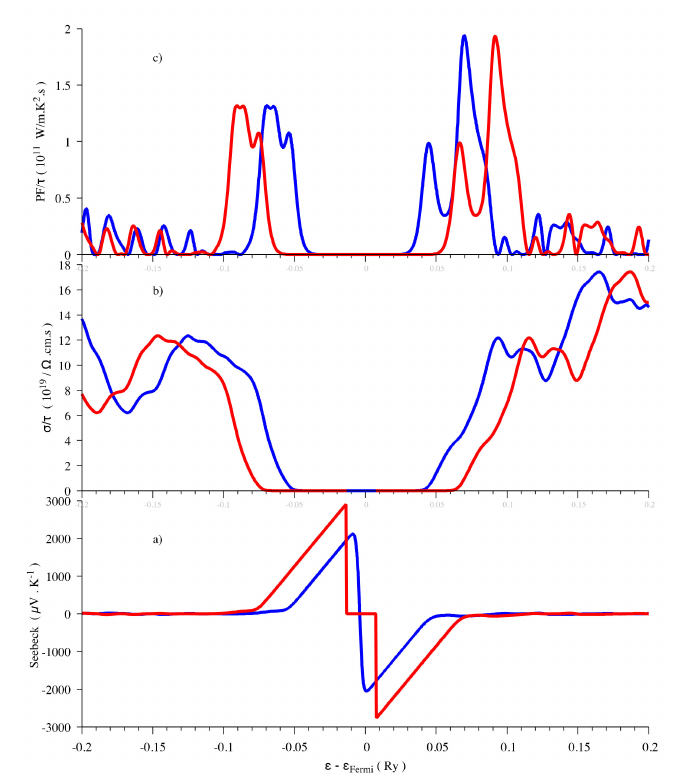
Figure 3. Thermoelectric properties (Seebeck coe ffi cient ( a ), electrical conductivity ( b ) and power factor ( c )) as a function of the chemical potential at 300 K for Sb 2 S 3 . Red curve, Eg = 1.88 eV and blue curve, Eg = 1.3 eV.